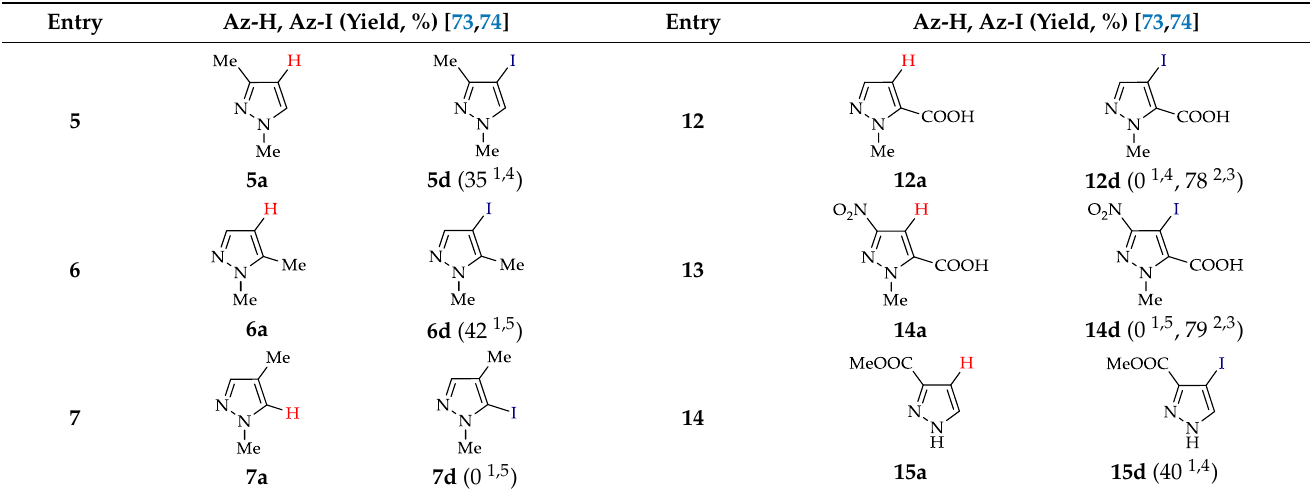
mmol), divided cell, Pt anode, Cu cathode, galvanostatic electrolysis ( j anode = 7.5 mA ‧ cm −2 ), Q = Q t = 1930 C; 2 two-step process: 1. electrogeneration of KIO 3 in 1M aq. KOH, 70 °C, KI (30 mmol), K 2 Cr 2 O 7 (0.7 mmol), undivided cell, NiO(OH) anode, Ni cathode, galvanostatic electrolysis ( j anode = 200 mA ‧ cm −2 ), Q t = 17370 C, Q/Q t = 0.9 – 1.1; 2. pyrazole (45 – 150